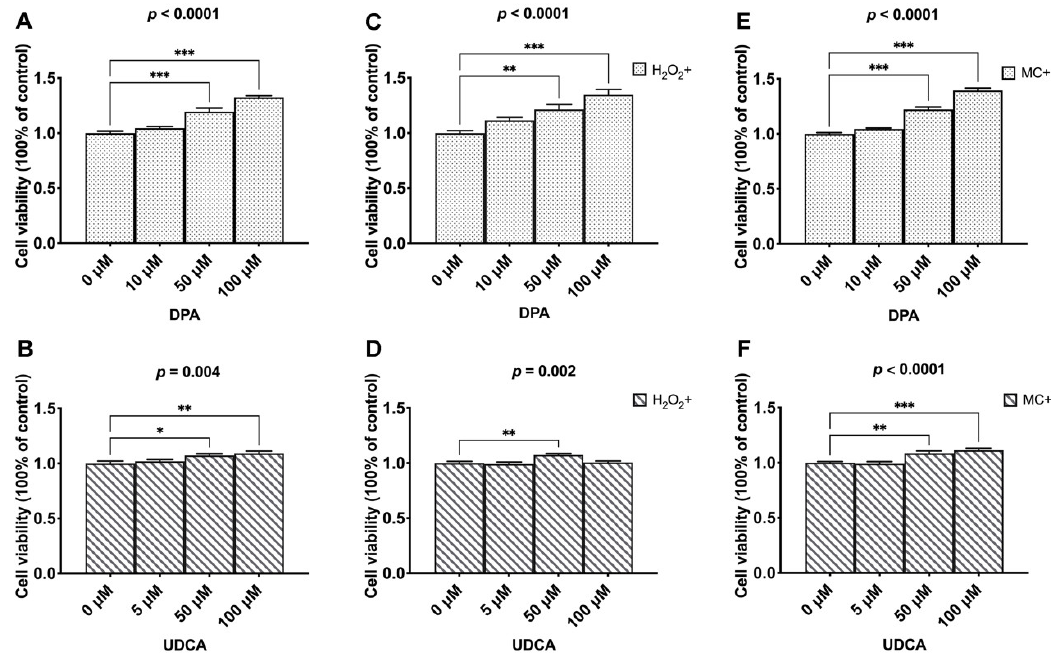
Figure 3. The effects of DAP and UDCA on the vitality and adaptation of the BMSCs. ( A , B ). The dosage effects of DPA and UDCA on the vitality of BMSCs. ( C , D ). The dosage effects of DPA and UDCA on the vitality of BMSCs in response to 250 μM hydrogen peroxide (H 2 O 2 )-caused oxidative stress damage. ( E , F ). The dosage effects of DPA and UDCA on the vitality of BMSCs in response to 1 μM mitomycin C (MC)-caused DNA damage. The data are presented as mean SEM (n = 7). ns indicates no significance ( p > 0.05); * p < 0.05; ** p < 0.01; *** p < 0.0001.